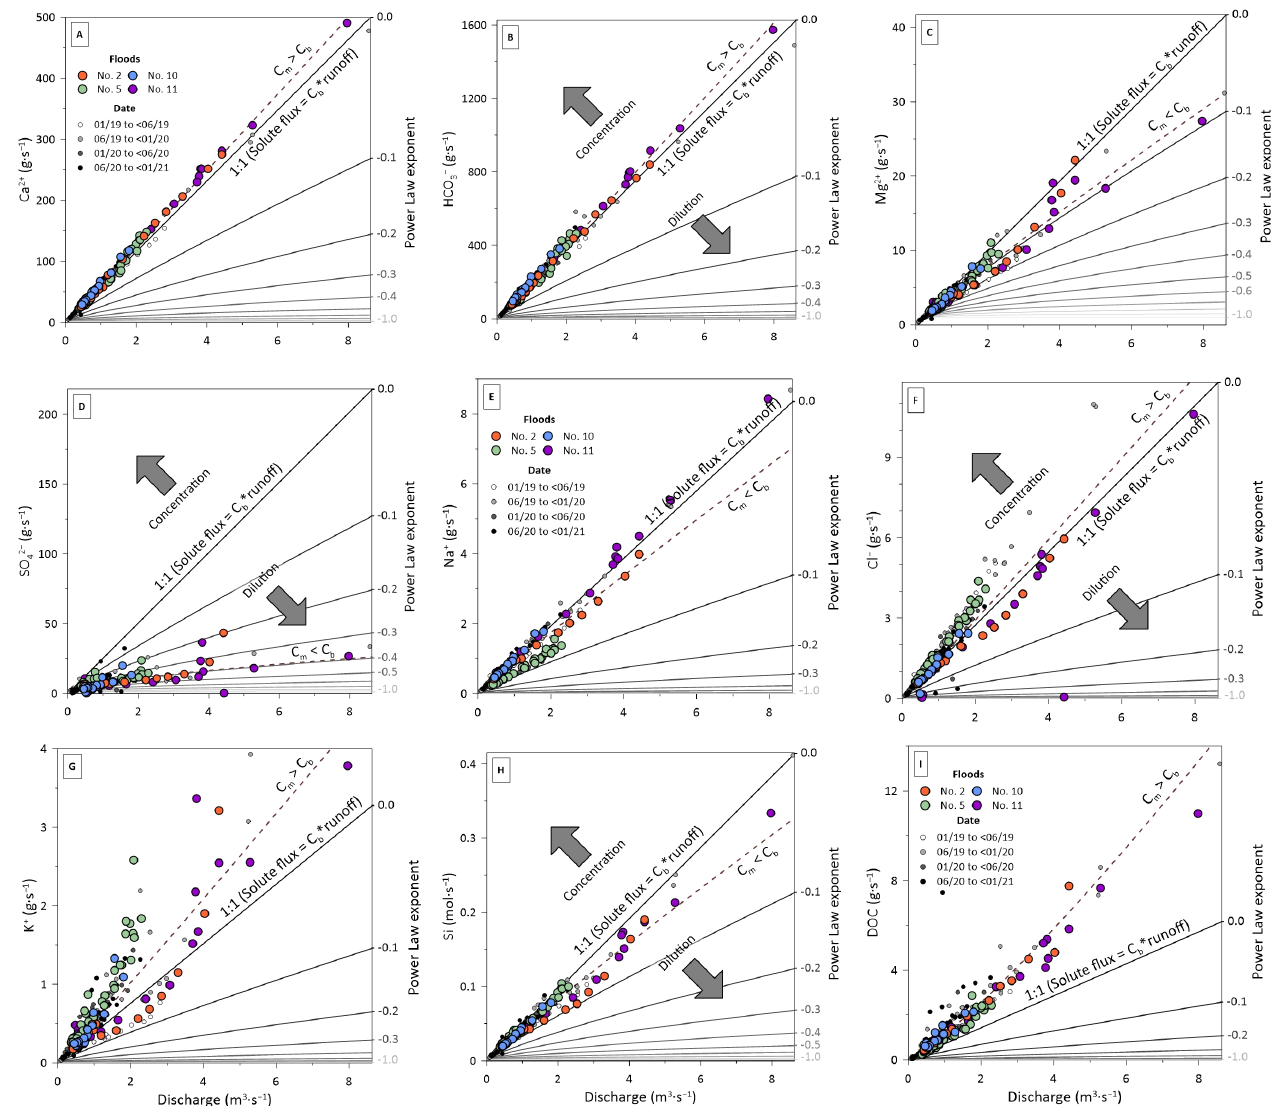
Figure 7. Relationships between the fluxes of the different major dissolved elements and the discharges (Q): ( A —) for Ca 2+ , ( B —) for HCO 3 − , ( C —) for Mg 2+ , ( D —) for SO 42 − , ( E —) for Na + , ( F —) for Cl − , ( G —) for K + , ( H —) for NO 3 − , and I —Si) − and ( I ) for Si. The power-law function is F = =C b *Q b+1 ;. b is the power law exponent shown in the figures. For b = =0 (base flow concentration), C b is the concentration when the discharge and flux were minimal during the study period (2019–2020). The dashed brown line is the trend line for the streamwaterstream water samples, whose slope is the mean concentration of each dissolved element (C m ). When Cm > >Cb, the cluster of points is above the line 1:1 (DOC, K + , Cl − , Ca 2+ , + and HCO 3 − ); − ), on the contrary, when Cm<Cb, the cluster of points is below the line (SO 42 − , Na + , Mg 2+ , + and Si).